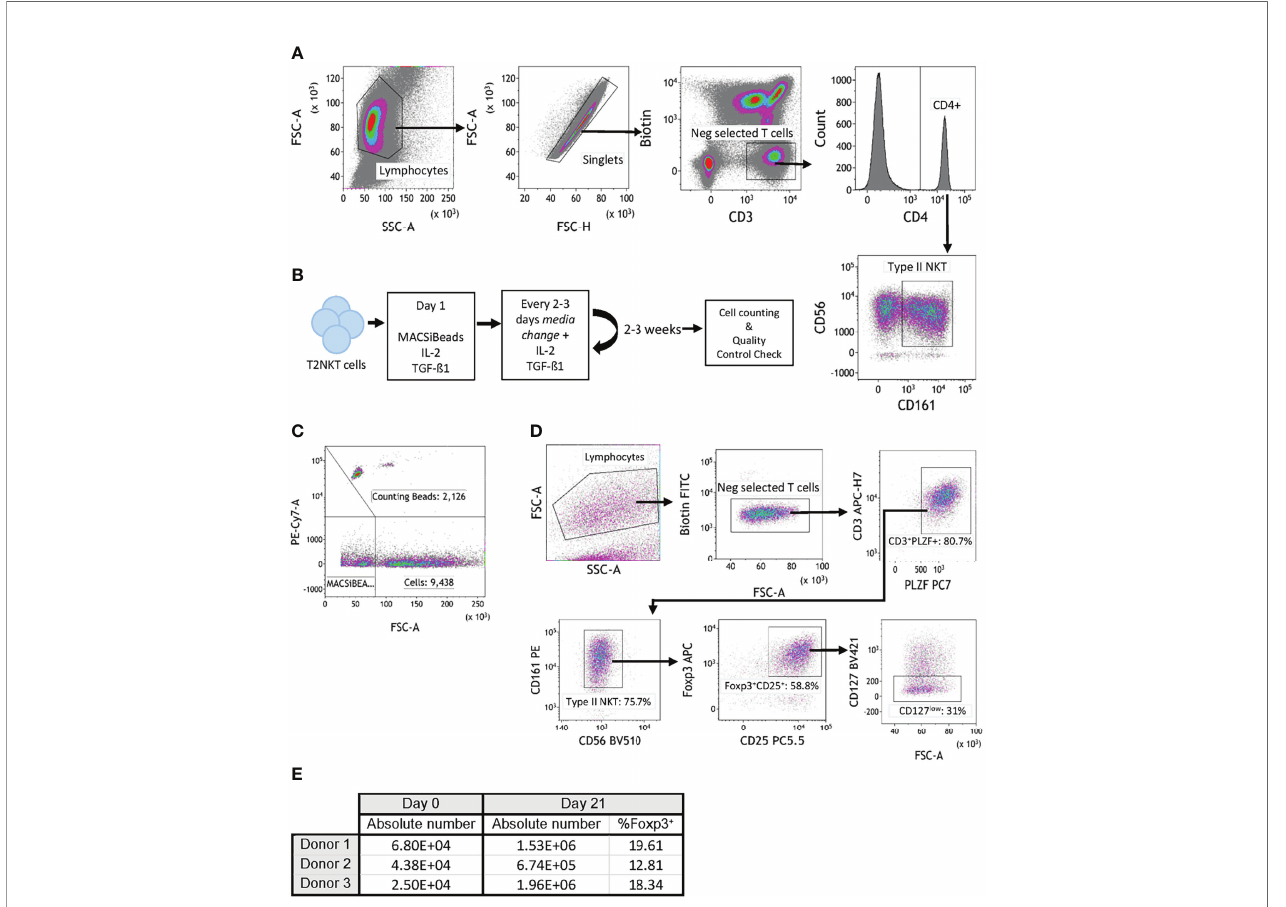
FIGURE 3 | In vitro expansion of FoxP3 + T2NKT cells. (A) Gating strategy to fl ow-sort T2NKT cell after double-step MACS enrichment. From left to right, cells were gated for lymphocytes based on FSC/SSC and singlets. Biotin FITC excluded cells labeled with TCRV a 7.2, TCRV a 24 or TCR g ᵹ antibody. Cells were then gated for CD3 + CD4 + CD56 + CD161 + . (B) Schematic map depicting each step of the expansion protocol. (C) Cell counting after 3 weeks expansion using Flow Cytometry Counting Beads. Counting beads were positive for PE-Cy7, cells were separated from MACSiBeads based on FSC. (D) Quality control analysis of T2NKT cell expansion after 3 weeks. Lymphocytes were separated from MACSiBeads and dead cells by FCS/SSC. MAIT cells, g ᵹ T cells and iNKT cells were excluded by staining with Biotin FITC. Within the CD3 + T cell population, PLZF was highly expressed (80.7% of the total lymphocyte population). These cells were mainly CD56 + CD161 + (75.7% of the total lymphocyte population) and a subset expressed regulatory-like phenotype FoxP3 + CD25 + CD127 low (31% of the total lymphocyte population). (E) Summary table indicating absolute number of cells before expansion (day 0) and after expansion (day 21). Percentage of FoxP3 + cells after expansion is